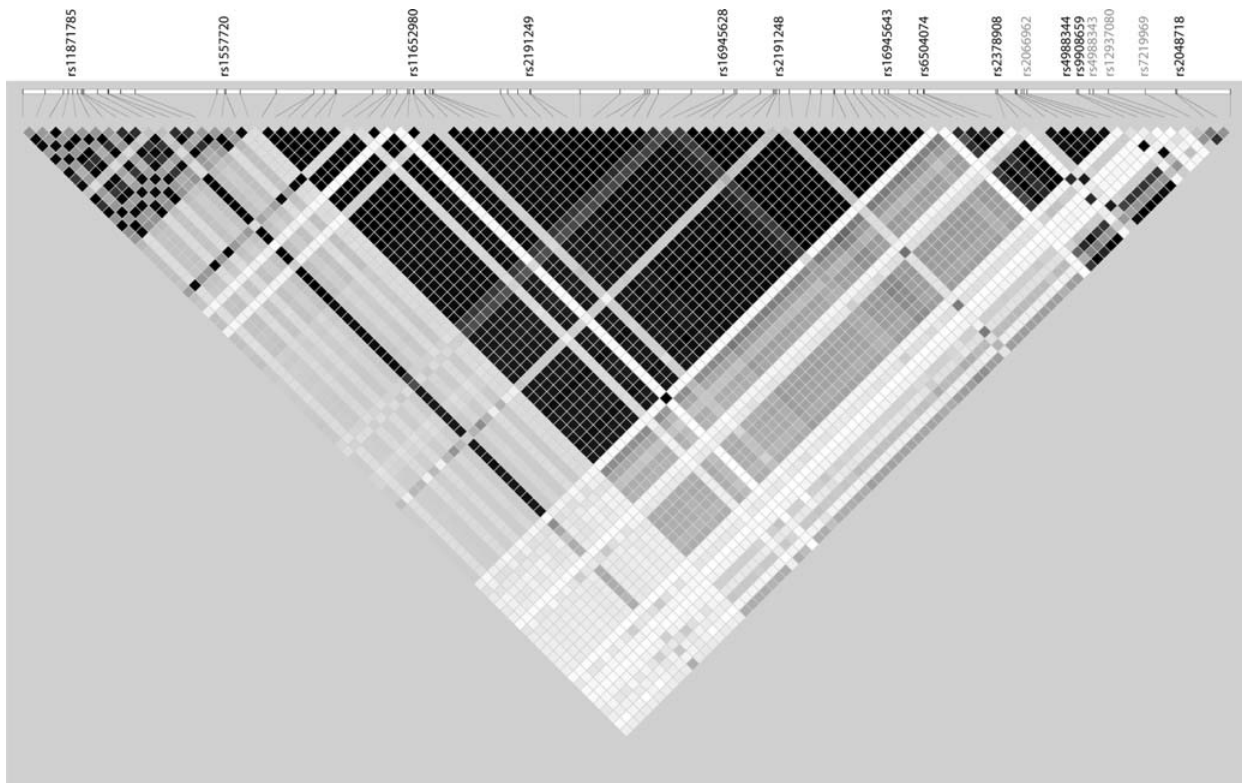
Figure 1. Linkage disequilibrium between the 92 common variants (MAF . 0.05) in HapMap CEPH trios. Each square represents the correlation (r 2 ) between each pair of SNPs with darker shades representing stronger LD. Tag SNPs are indicated with those SNPs that failed assay design being shown in grey font.